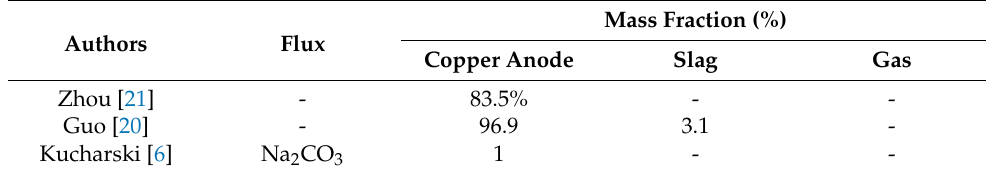
Table 3. The published data on arsenic distribution during fire refining.